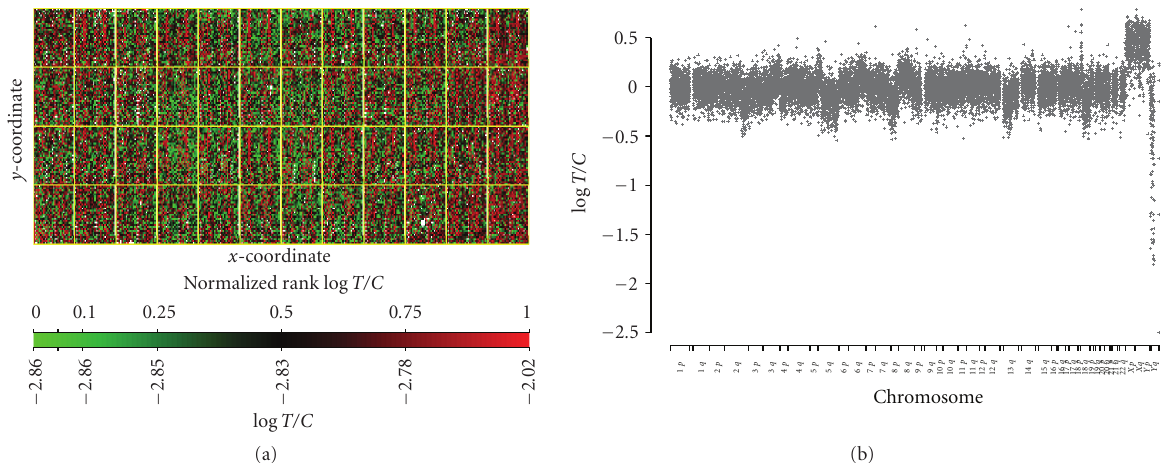
Figure 3: Intensity correction results: The aCGH data from Figure 1 after removing the intensity e ff ects shown as a function of (a) location on the array (b) and genomic location. The genomic profile was created by averaging the signal for the two replicates of each BAC clone.